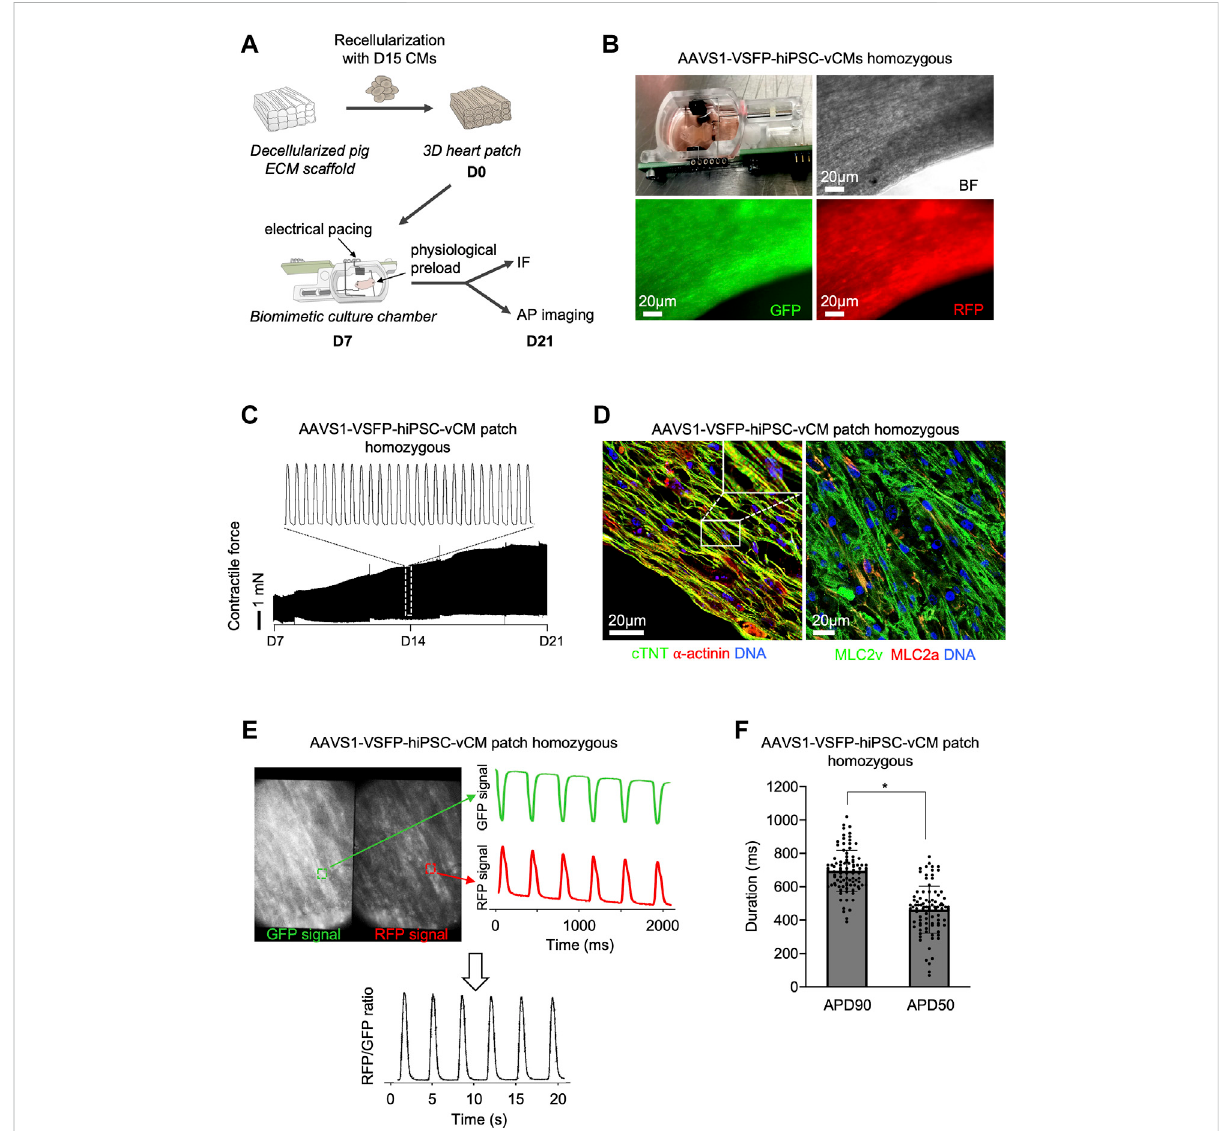
FIGURE 4 Optical AP recordings in single ventricular AAVS1-VSFP-hiPSC-CMs within 3D heart patches. (A) Graphic representation of the experimental setup for 3D culture of hiPSC-derived CMs. Day 15 hiPSC-derived ventricular CMs were reseeded on decellularized pig ECM scaffold, which were transferredto biomimeticculturechambers undcultured undermechanicalload andelectrical pacingfor2weeks allowingcontinuous recordingof thecontractileforces.IF:immuno fl uorescence. (B) Animagedepictingthe3Dheartpatchinthebiomimeticculturechamber(upperpanelleft). Bright fi eld (BF), GFP and RFP live images of the 3D scaffold recellularized with AAVS1-VSFP-hiPSC-vCMs. (C) Representative contractile force traces from 3D heart patches reseeded with AAVS1-VSFP-vCMs during 2 weeks of culture in biomimetic chamber (lower panel). White dotted rectangle presentsazoomintothecontractileforceperformanceatday14(upperpanel). (D) Representativeimagesofa3Dheartpatchafter2weeksinculture immunostained with antibodies against cTNT (green) and ⍺ -actinin (red) (left) as well as MLC2v (green) and MLC2a (red) (right). Nuclei were labeled withDAPI(blue).Whiterectanglerepresentsazoomintothespeci fi cregionofcTNTand ⍺ -actininstaining. (E) SpontaneousopticalAPrecordingina 3D heart patch. Representative GFP and RFP imagesof a3D construct. Selected fi elds (white dotted rectangles) represent a ROI used to quantify the GFP and RFP fl uorescence signal (left panel). Background-corrected GFP and RFP fl uorescence signals derived from the ROI (right panel). The APs were calculated as RFP/GFP ratio (lower panel). (F) Quanti fi cation of APD90 and APD50 in 3D heart patches. Data are mean ± SD; N = 96 CMs from n = 3 patches; * p < 0.0001 (Mann-Whitney